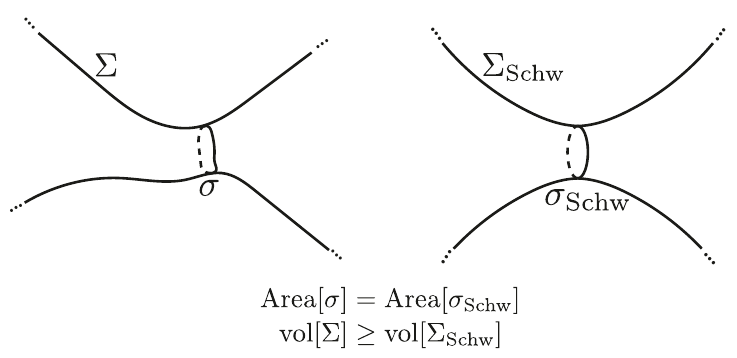
Figure 1 . Illustration of the volume comparison theorem at fixed throat area. Σ Schw is a static slice of Schwarzschild, while Σ is a maximal volume slice anchored at a static boundary